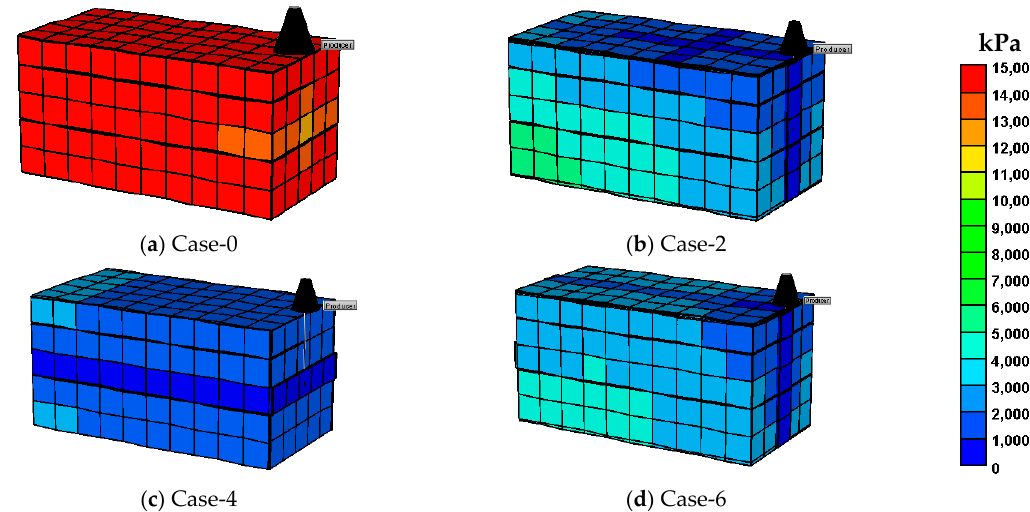
Figure 9. Pressure comparison between different scattered fractures in the depletion process.